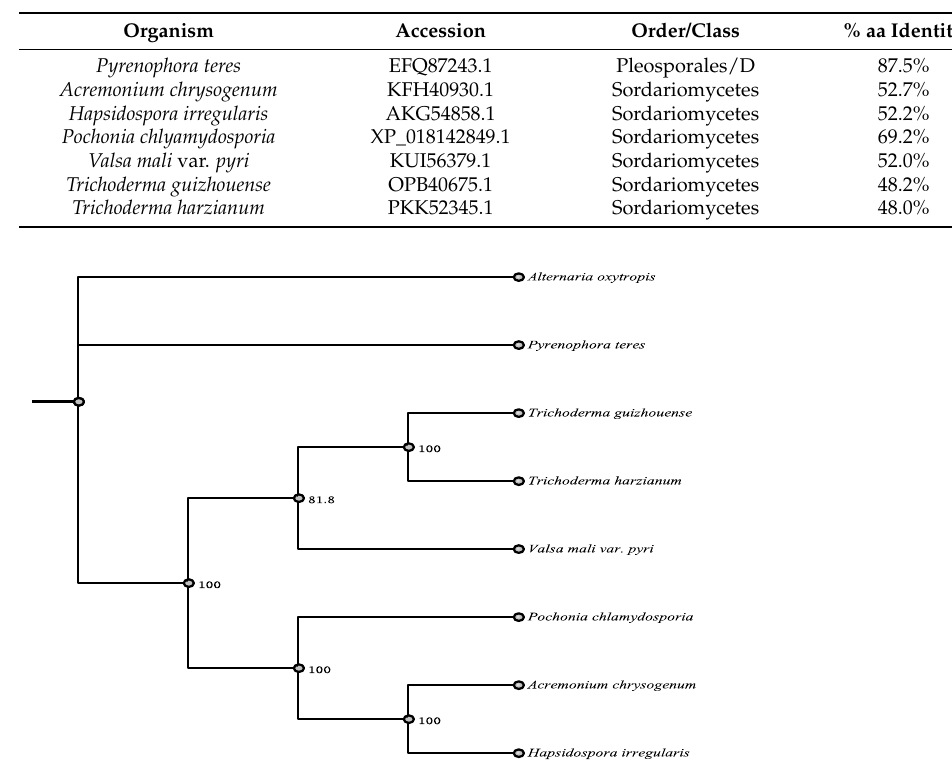
Table 4. Percent amino acid identity of pblast results of PKS-NRPS 21438 sequence. Fungal order if within the class Dothideomycetes (D) or other fungal class as listed.